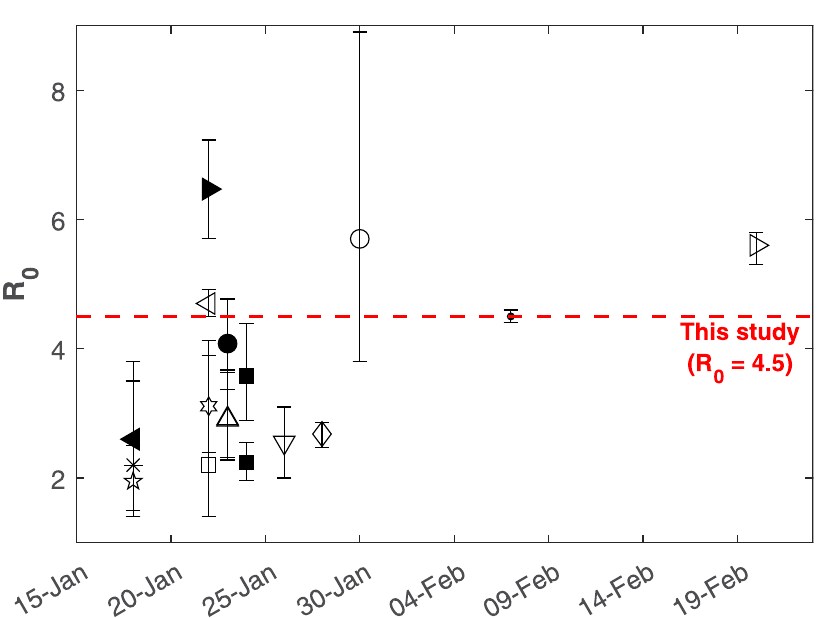
Fig 1. Timeline of the COVID-19 R estimates. Symbols represent studies listed in Appendix (Table 1) while the red o dashed line marks R o = 4.5 derived from this study. An initial R o = 2.2 was initially adopted by the World Health Organization (WHO).